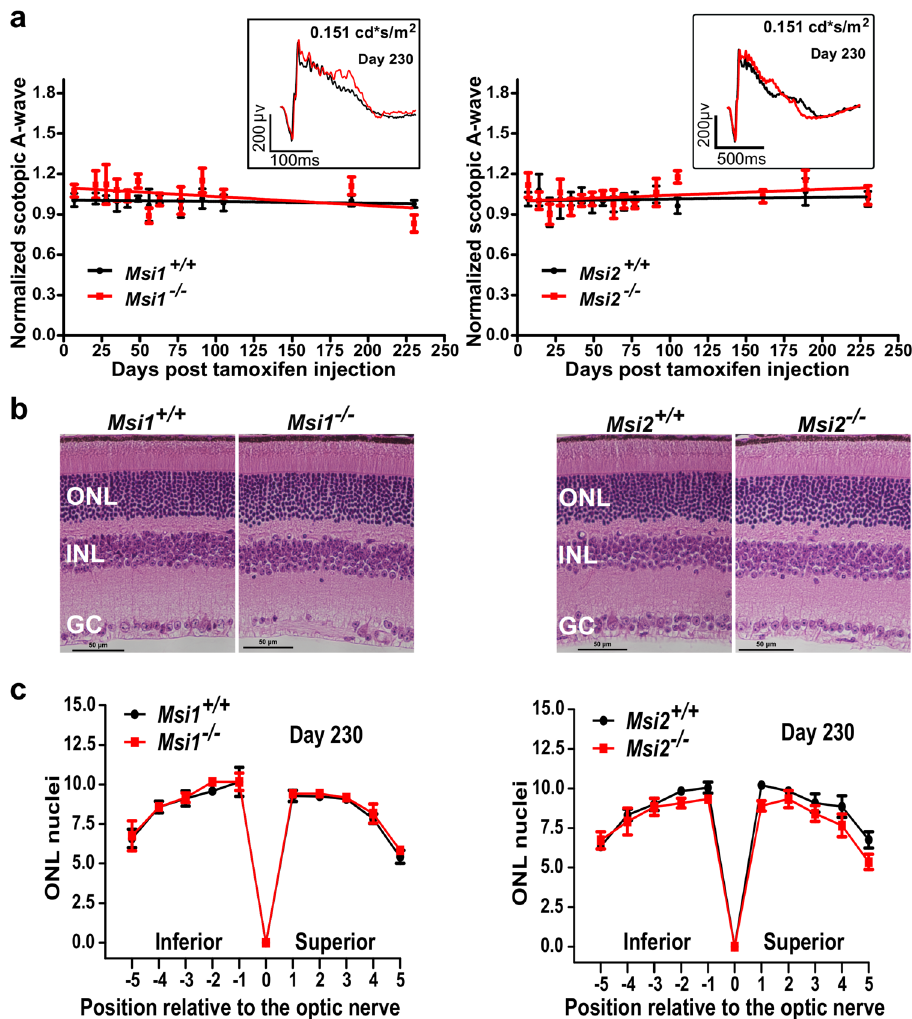
Fig. 4 Normal photoreceptor response to light and retinal morphology in the single knockouts Msi1 or Msi2 in photoreceptor cells. a Scotopic mean A-wave response from single Msi1 − / − (left) or Msi2 − / − (right) knockouts in photoreceptors (red lines) and littermate controls (black lines) recorded between 0 and 230 days post-tamoxifen injection. Scotopic waveforms were obtained using 0.151 cd-s/m 2 fl ashes. The insets of panels A and B show representative scotopic (dark-adapted) electroretinograms from a single knockout (red) or control (black) retina at D230 post-injection using 0.151 cd-s/ m 2 fl ashes. Scotopic waveforms were obtained after overnight dark adaptation using 0.151 cd-s/m 2 fl ashes. b Representative H&E-stained sections from retinas of single Msi1 − / − (left) or Msi2 − / − (right) knockouts in photoreceptor cells and littermate controls collected 230 days post-tamoxifen injection. ONL: outer nuclear layer (Photoreceptor nuclei), INL: inner nuclear layer, GC: ganglion cells. 40X objectives, scale bar, represents 10 μ m. c Spider plots of ONL thickness for single Msi1 − / − (left) or Msi2 − / − (right) knockouts (red) and littermate controls (black). The plots display the thickness of the ONL as the number of nuclei measured at ten points stepped by 400 µ m from the optical nerve in retinas collected 230 days after tamoxifen injection. Data are shown as mean ± SEM of 8 eyes, from four animals. Supplementary Data 15 contains the source data underlying the